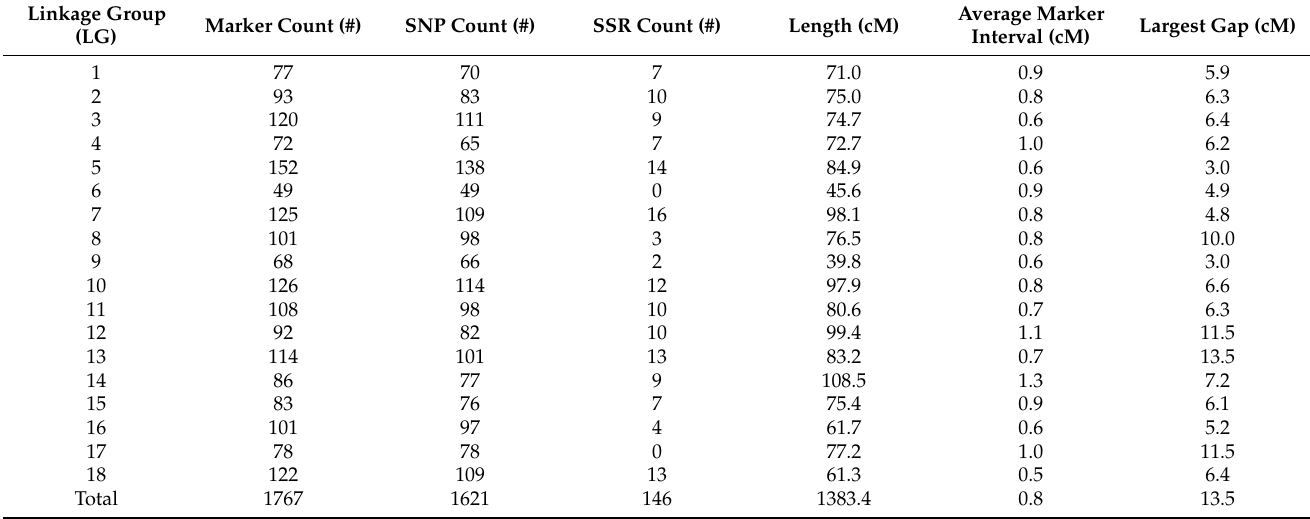
Table 2. Summary of the Hydrangea consensus